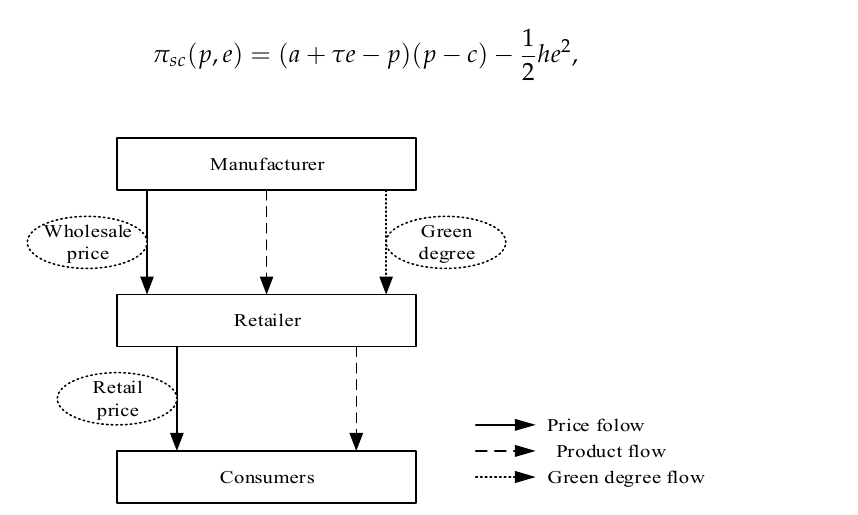
Figure 1. Green supply chain with an environmentally conscious manufacturer, a retailer, and consumers.